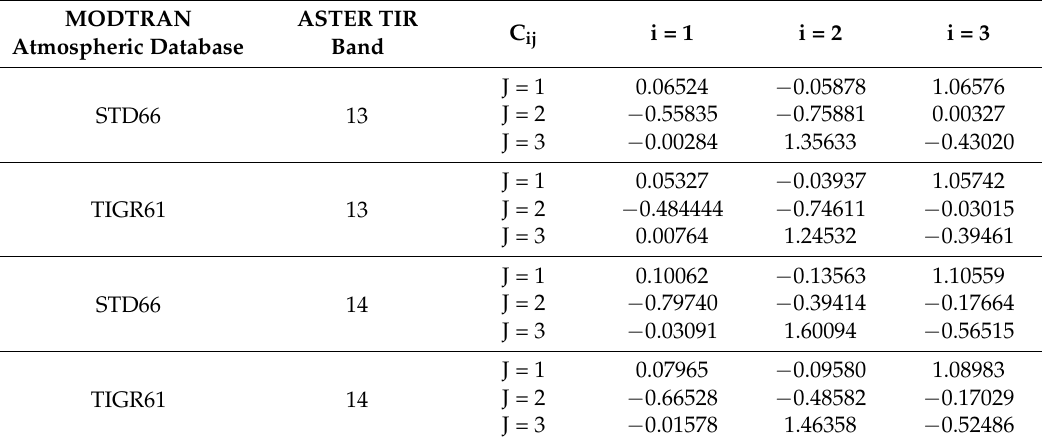
Table 6. Coefficients of the AFs